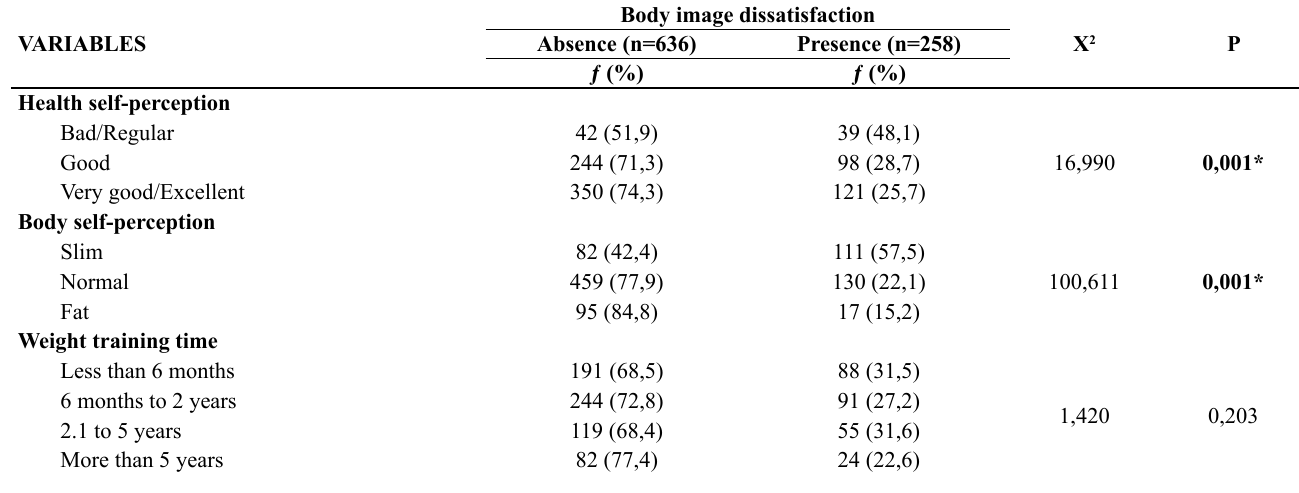
Table 4 . Association between body image dissatisfaction and the variables related to health and physical activity of weight training practitioners in Maringá, Paraná,